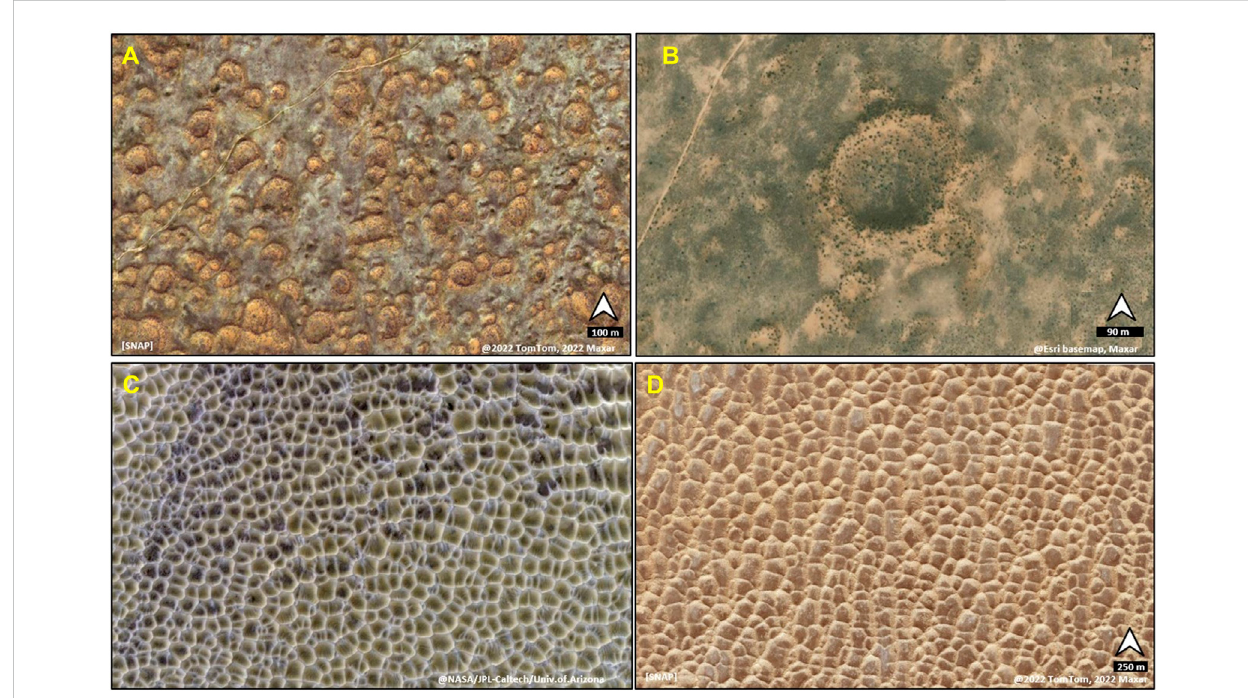
FIGURE 13 Uncertain dune types. (A) bowl-like formations snapped from ©Bing Maps Aerial Imagery and adapted. (B) Fully stabilized bowl-like form, with partially vegetated bounding ring and adapted from Esri (C) Martian honeycomb dunes, taken from NASA of fi cial webpage (D) Karakum honeycomb pattern snapped from ©Bing Maps Aerial Imagery and